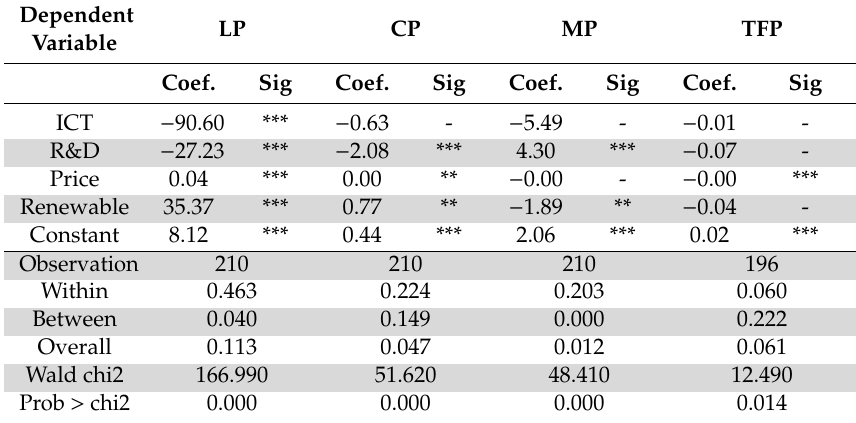
Table 3. The results of the determinant analysis using integrated information and communications technology (ICT) capital data.